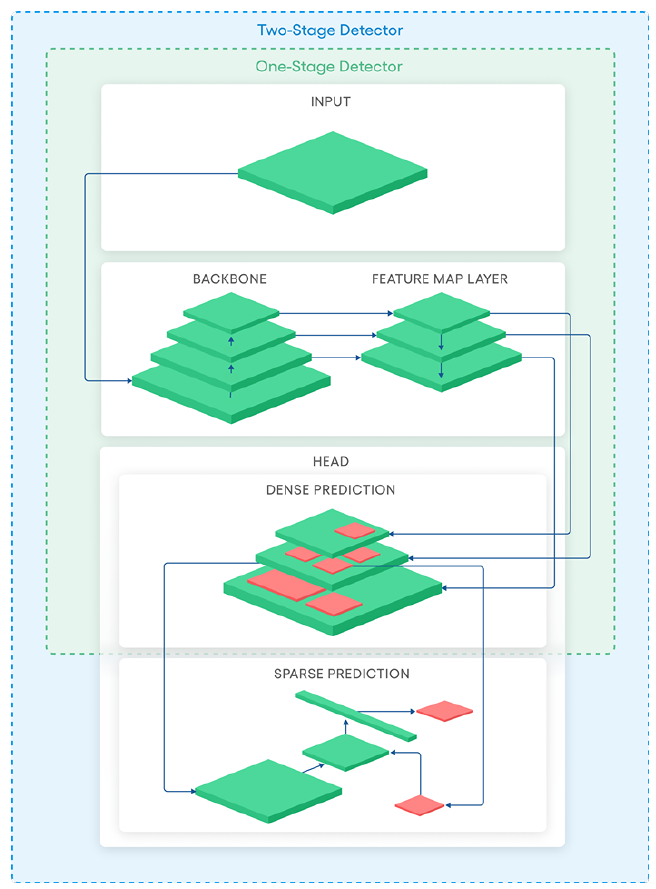
Figure 1. A schematic diagram for comparison of one-stage and two-stage object